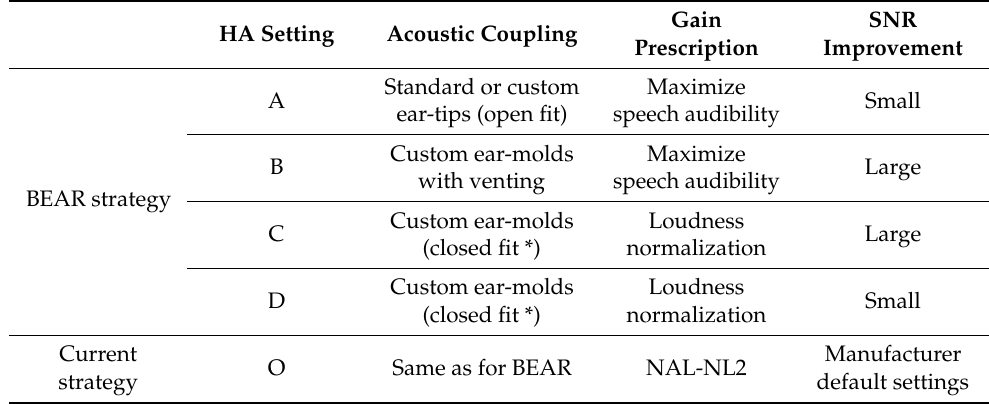
Table 1. Summary of the key properties (acoustic coupling, gain prescription, and SNR improvement) for implementing the BEAR rationale in commercially available devices. HA